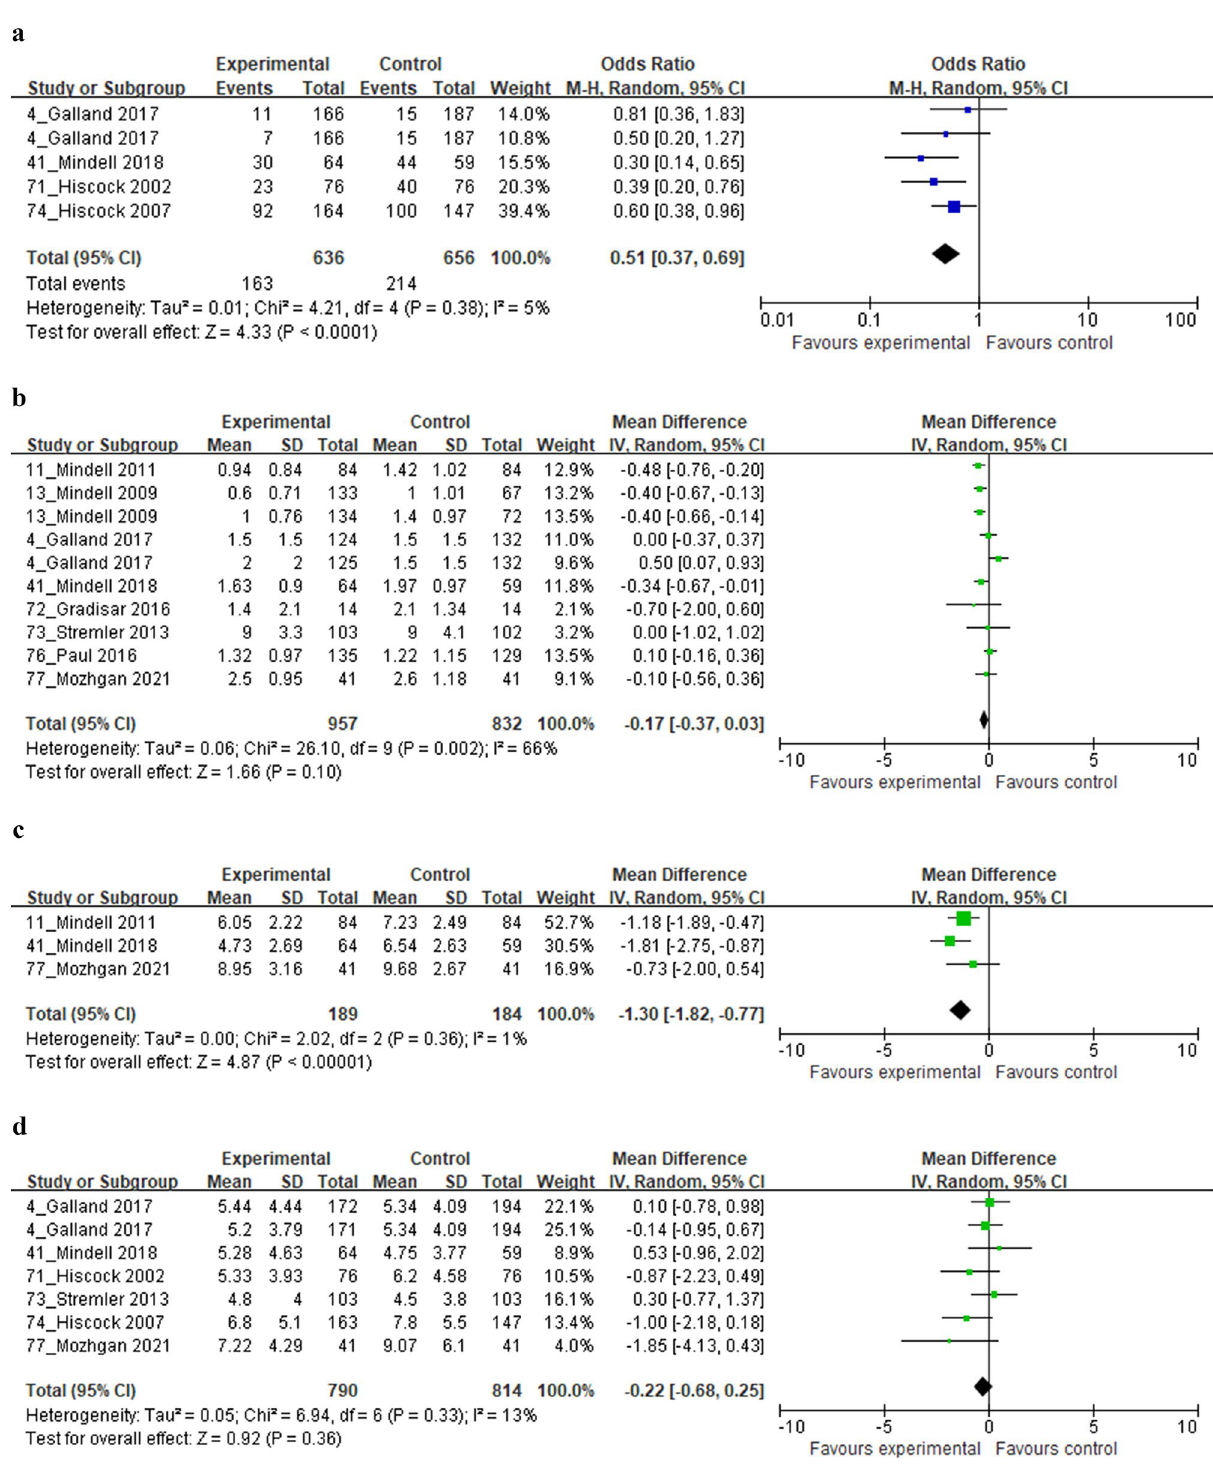
Figure 3. Forest plot comparing the effects of behavioral sleep intervention. ( a ) Child sleep problems reported by mothers, ( b ) Child night awakenings, ( c ) Maternal sleep quality, and ( d ) Maternal